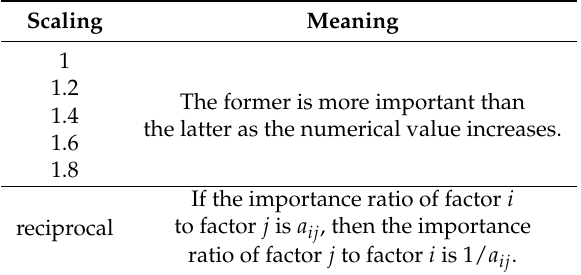
Table 1. Scaling